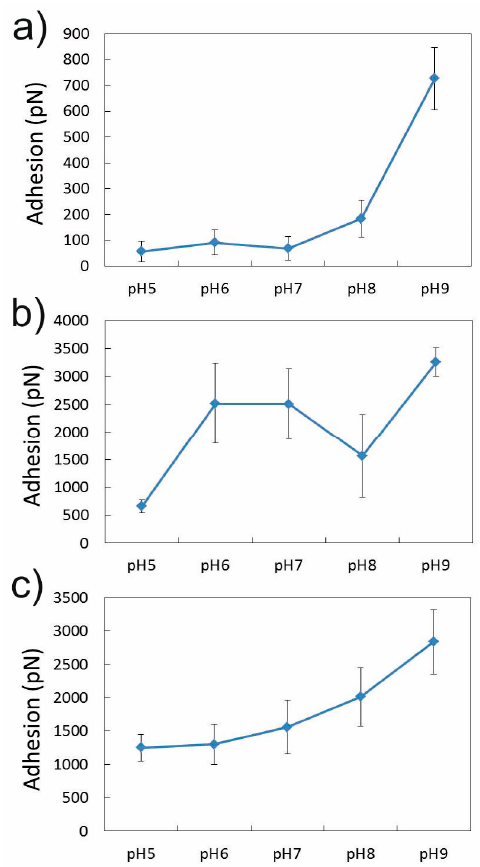
Figure 6. Graphs showing the measured adhesion from experiments kao-Si-4 ( a ), kao-Si-5 ( b ) and kao-Si-6 ( c ), where the overall effect of pH on the adhesion of a –COOH functionalised probe was measured in the presence of a 0.001 M CaCl 2 solution. An overall increase in adhesion as pH is increased can be observed.